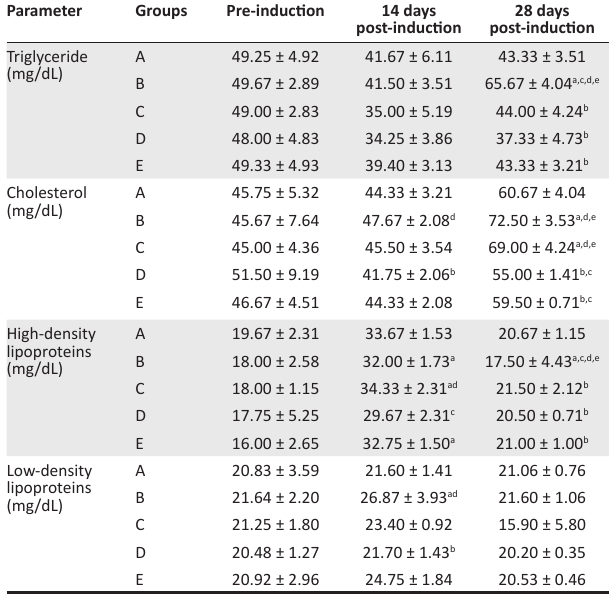
TABLE 8: Effect of Vernonia amygdalina on serum lipid profile of alloxan-induced diabetic rats.